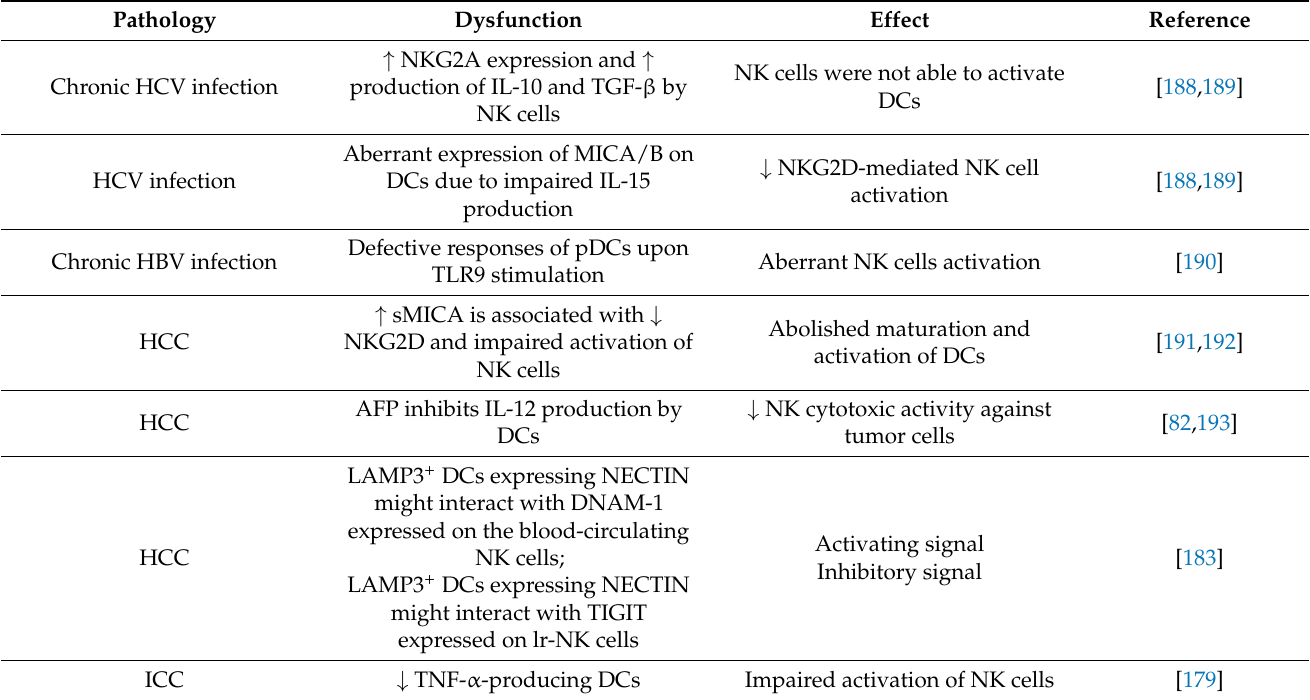
Table 1. Overview of findings on NK–DC crosstalk in liver